Question: Write a descriptive caption for this figure.
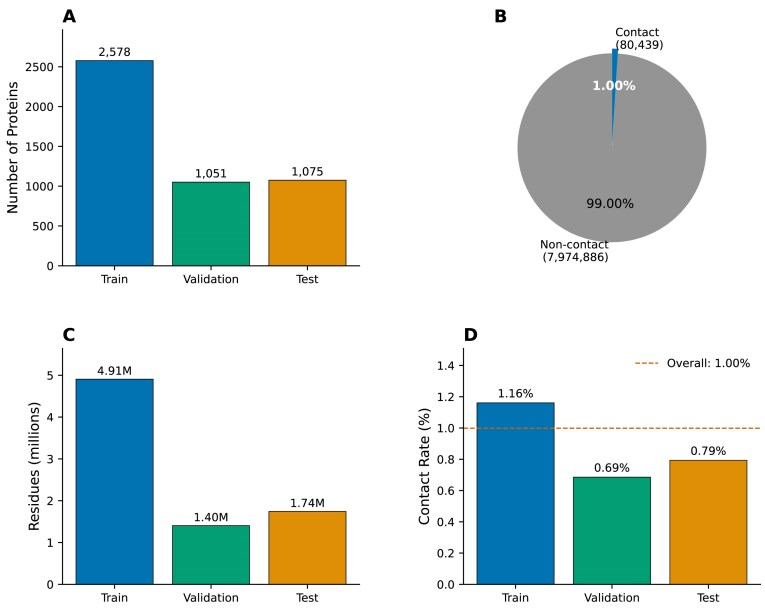
Answer: MPLID dataset overview. (A) Distribution of proteins across training (54.8%), validation (22.3%), and test (22.9%) splits. (B) Class distribution showing the imbalance between contact (1.00%) and non-contact (99.00%) residues. (C) Total residues per split. (D) Contact rates across splits, showing variation due to cluster-level stratification: training (1.16%), validation (0.69%), and test (0.79%).